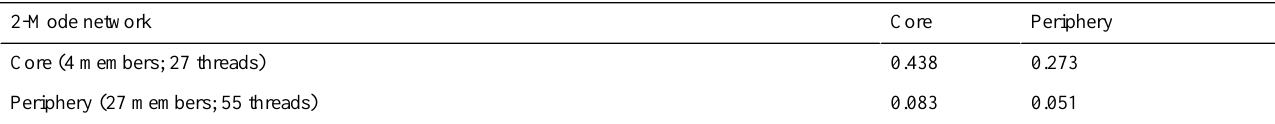
Table 3. Communication densities stratified by the core-periphery structure in the 2-mode network.